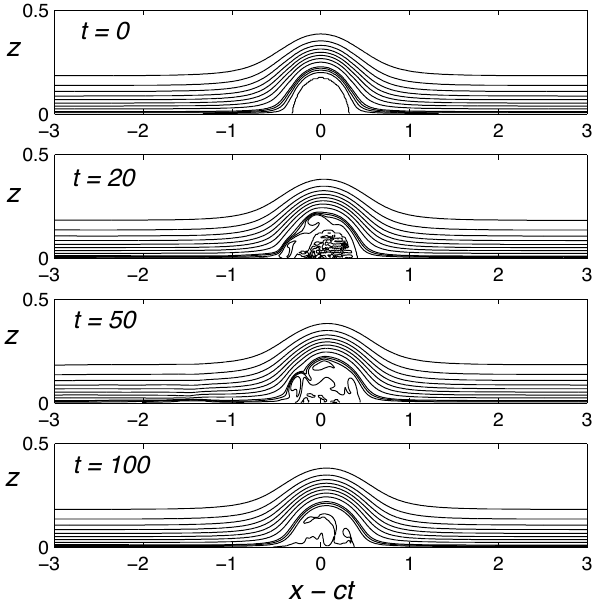
Fig. 9. Evolution of a stagnant-core DJL solution for λ = 8, s c = 1, and c = 0 . 4. The panels show contours of s at the times indicated. The contour intervals are 0.1 for s ≤ 0 . 9 and 0.025 for s > 0 . 9. Note that only the lower half of the domain is shown.